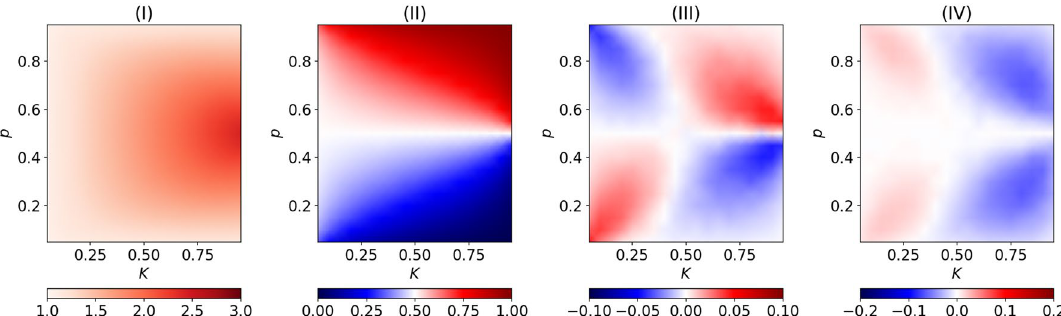
Figure 4. Simulations of the double one shot prisoner dilemma: (I) Average reward with A = 0 ; (II) Rate of intuitive play of action F when A = 0 ; (III) Variation in the rate of intuitive play of action F passing from A = 0 to A = 1 ; (IV) Variation in the average reward passing from A = 0 to A = 1